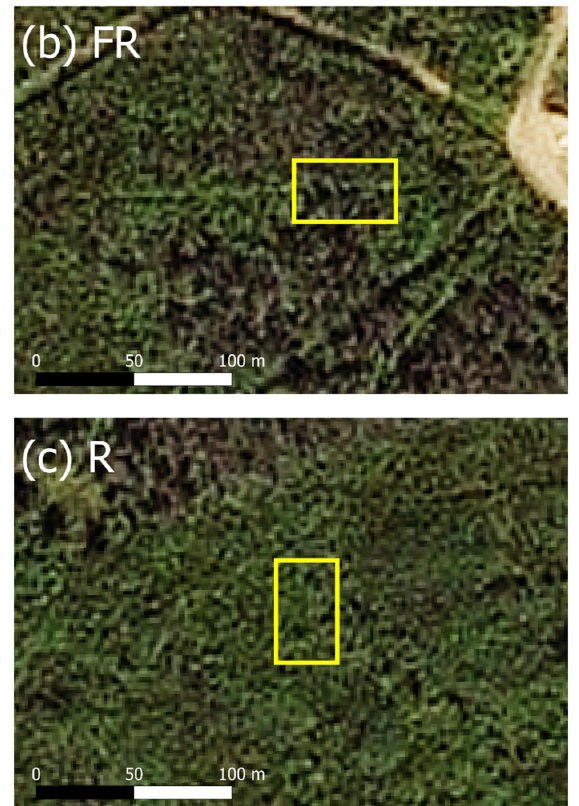
Figure 3. Examples of the recovery classification categories: ( a ) Not Recovered (NR), ( b ) Fractionally Recovered (FR), and ( c ) Recovered (R) shown on satellite imagery © (2021) Airbus Defence and Space, Licensed by Planet Labs Geomatics Corp., http://geomatics.planet.com/ (accessed on 20 November 2020). The yellow rectangle marks the 55 m long sampling transect location. Image was created using QGIS version 3.16.0 [16].